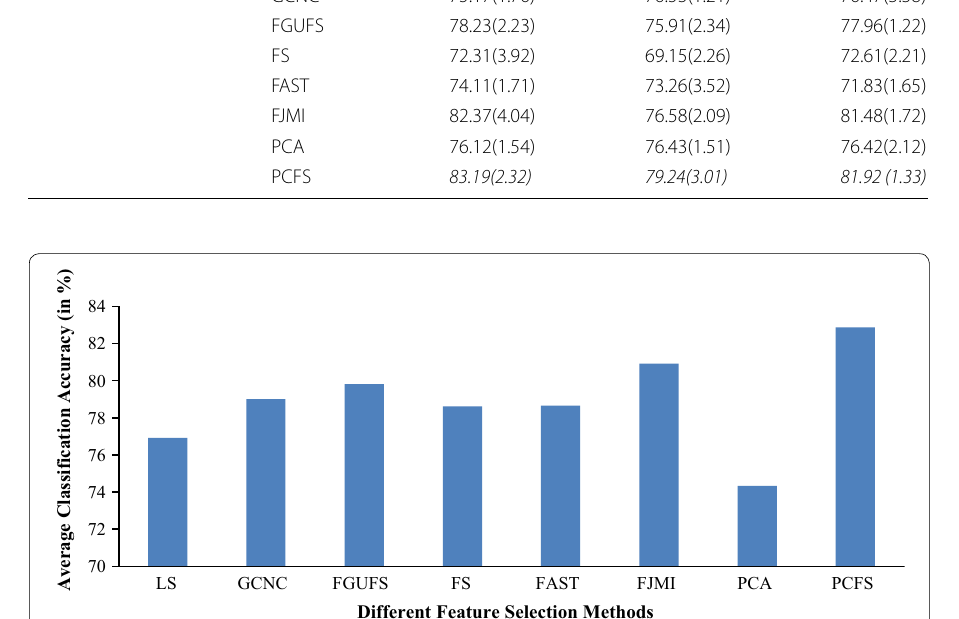
Fig. 1 Average classification accuracy over all datasets on the SVM classifier